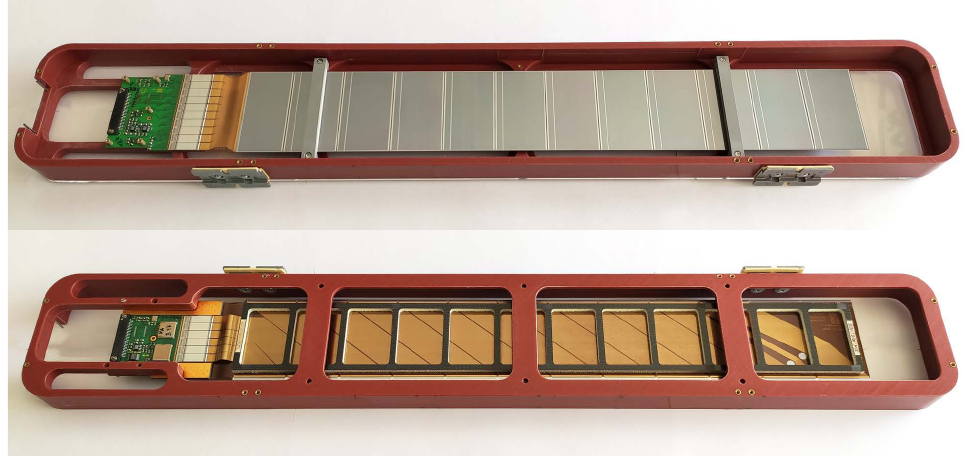
Figure 8. Picture of an AMS-02 ladder made of 12 double-sided 40 × 70mm 2 silicon microstrip sensors, enclosed in a plastic transport box. Strips measuring the bending direction are readout using a daisy-chain microbonding connection (top view), while transversal strips are readout via additional routing provided by a metalized Upilex film (bottom view), such that the FEE readout is located at the longitudinal edge of the